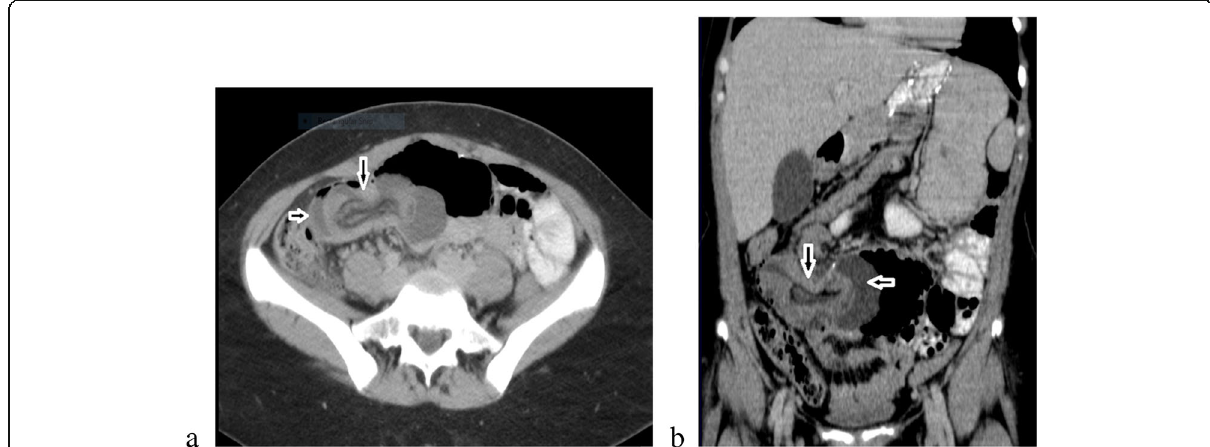
Fig. 6 A thrirty-four-year-old female patient presented 2 years post-Roux-en-Y gastric bypass by abdominal pain and diarrhea. a , b MSCT axial and coronal reconstruction images show complex mass seen at right lower abdominal quadrant ( white arrow) showing edematous bowel loops wall with bowel-within-bowel configuration (target appearance). Small bowel intussusception post-GRYB